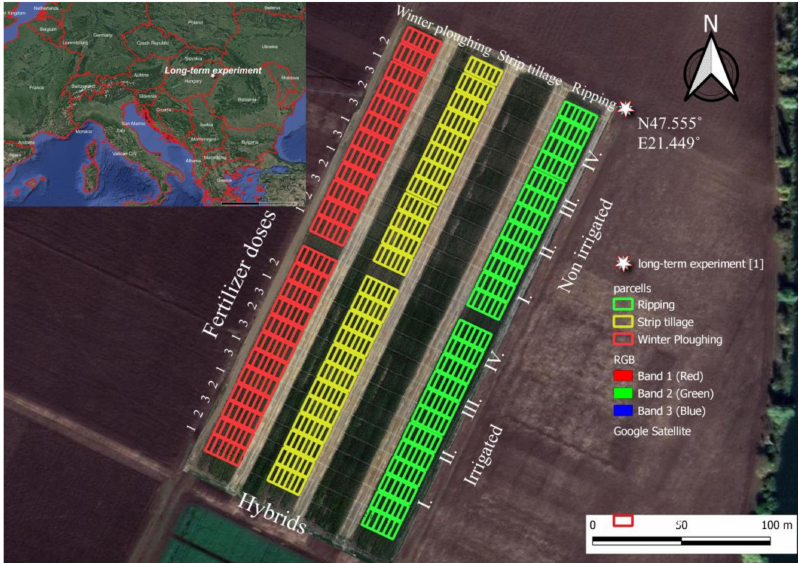
Figure 1. Field map with basemap of RGB image of 1 July 2021 and location in Hungary. Note: